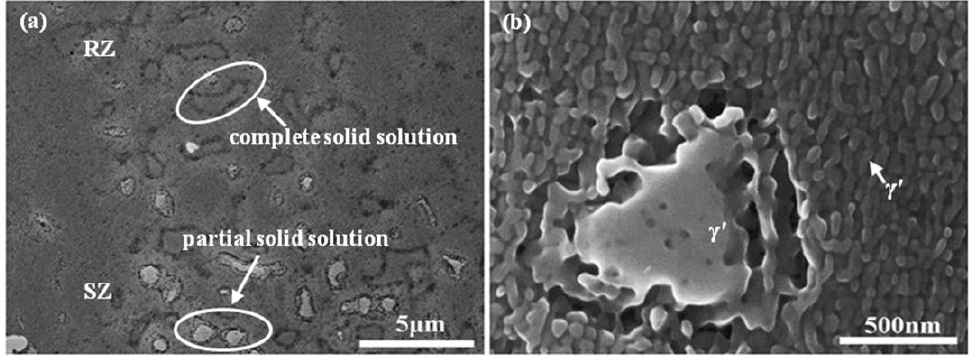
Figure 6. Phase transition of intragranular γ′ in HAZ: ( a ) low magnification and ( b ) high magnification.